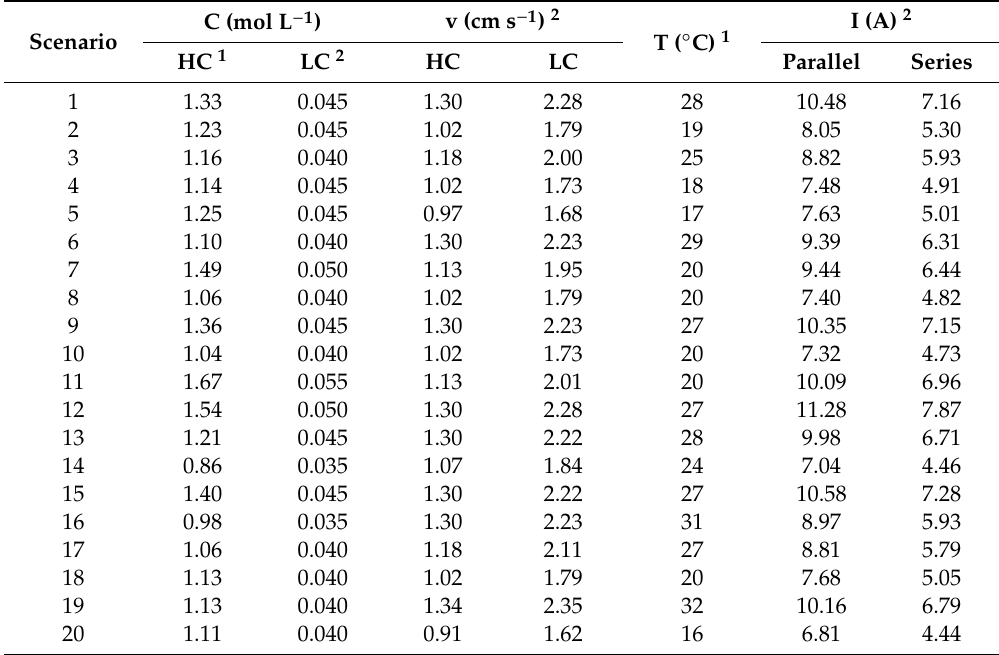
Table 3. Working conditions of the RED stack for each scenario and RED plant’s layout.